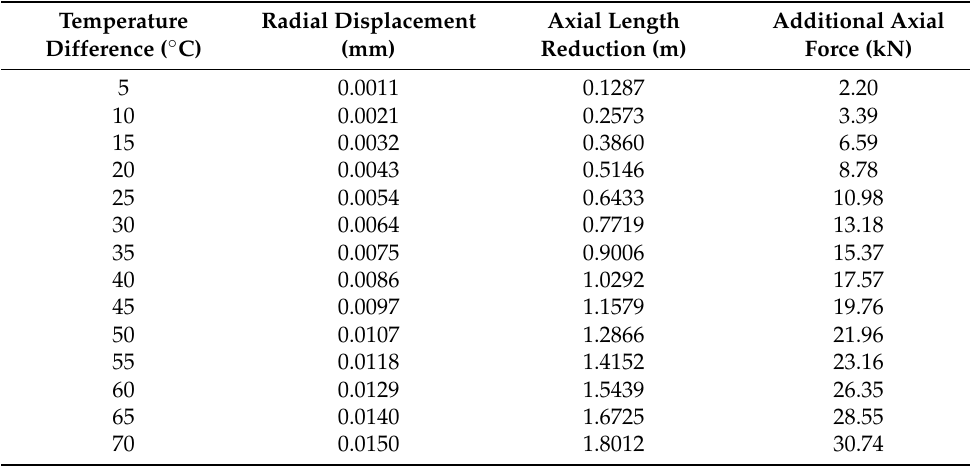
Figure 5. Change of the casing axial length and additional axial force under different temperature ture difference. difference. Table 3. Casing deformation and additional stress under different temperature Table 3. Casing deformation and additional stress under different temperature difference.